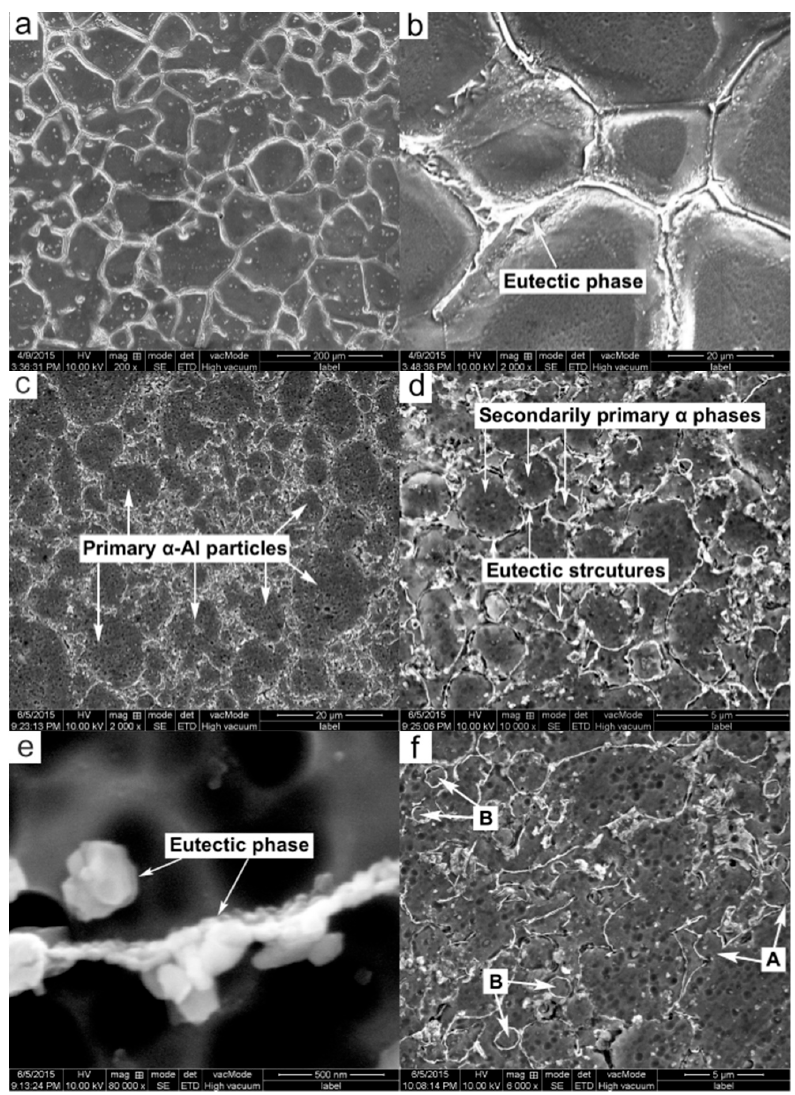
Figure 2. SEM images of: ( a , b ) PMC-6061 alloy; ( c – f ) PTF-6061 alloy.